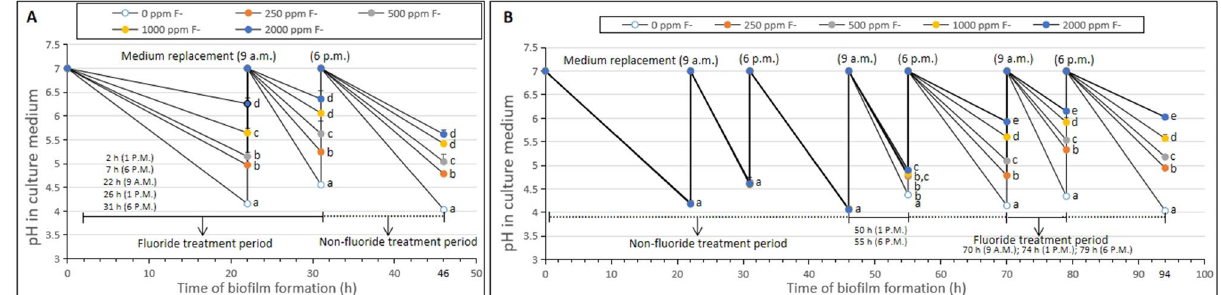
Figure 2. Change in the pH values of old culture medium treated with different concentrations of fluoride during 46/94-h-old S. mutans biofilms formation. ( A ) 46-h-old S. mutans biofilms ( p < 0.05). ( B ) 94-h-old S. mutans biofilms (22, 31, 46 h, p > 0.05; 55, 70, 79, 94 h, p < 0.05). Data represent mean ± standard deviation. * p < 0.05: significantly different from each other. p > 0.05: values followed by the same superscript are not significantly different from each other.